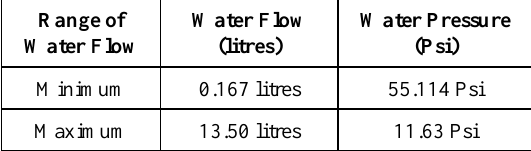
Table 2 . Range of water pressure value if there have water flow.